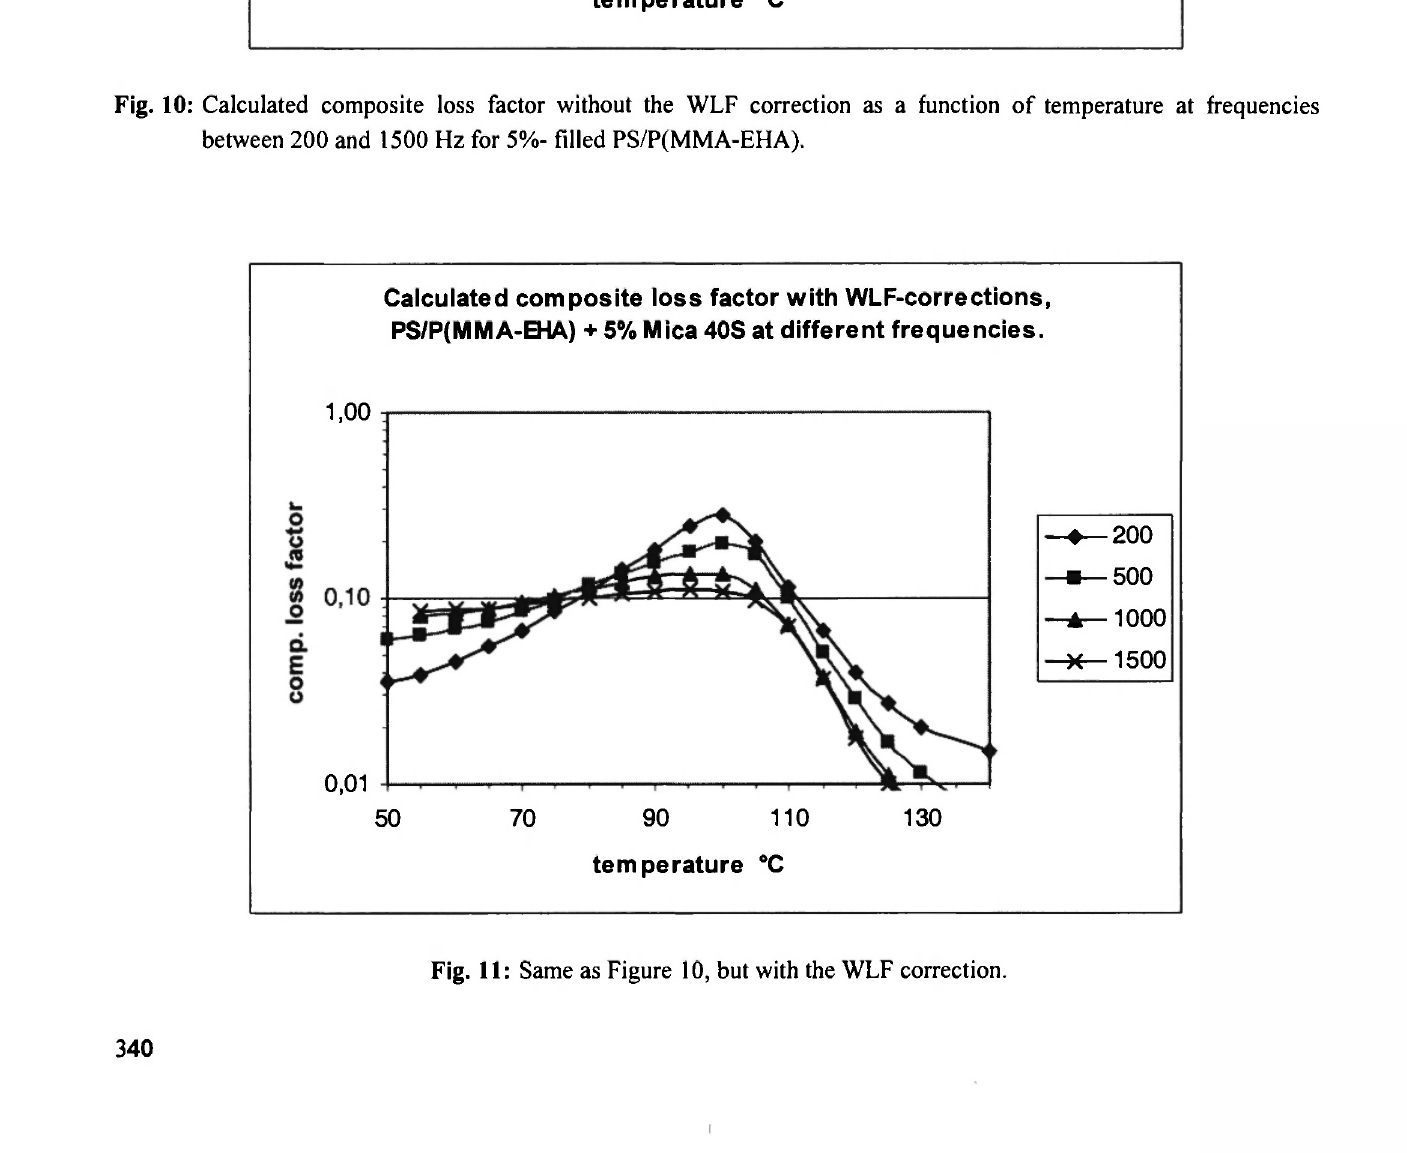
Fig. 11: Same as Figure 10, but with the WLF